Question: Write a descriptive caption for this figure.
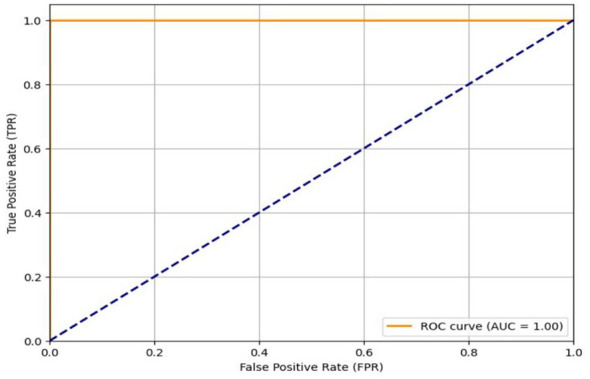
Answer: ROC curve of the proposed model.